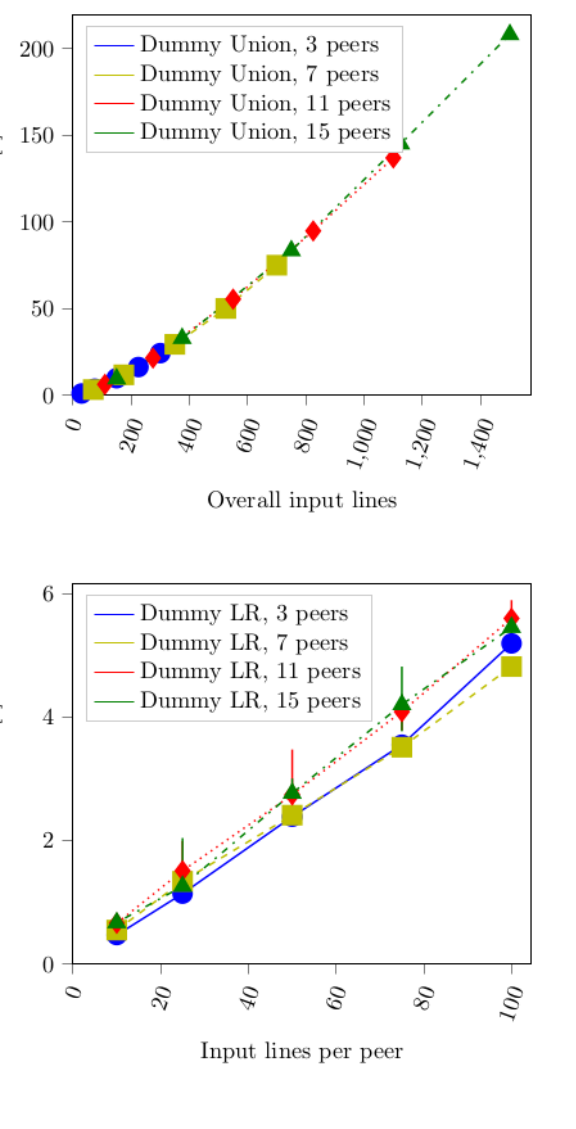
Figure 3. Central processing unit (CPU) time depending on the number of input lines and peers. LR: